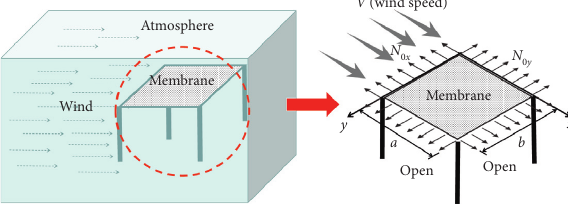
Figure 3: The membrane roof on open